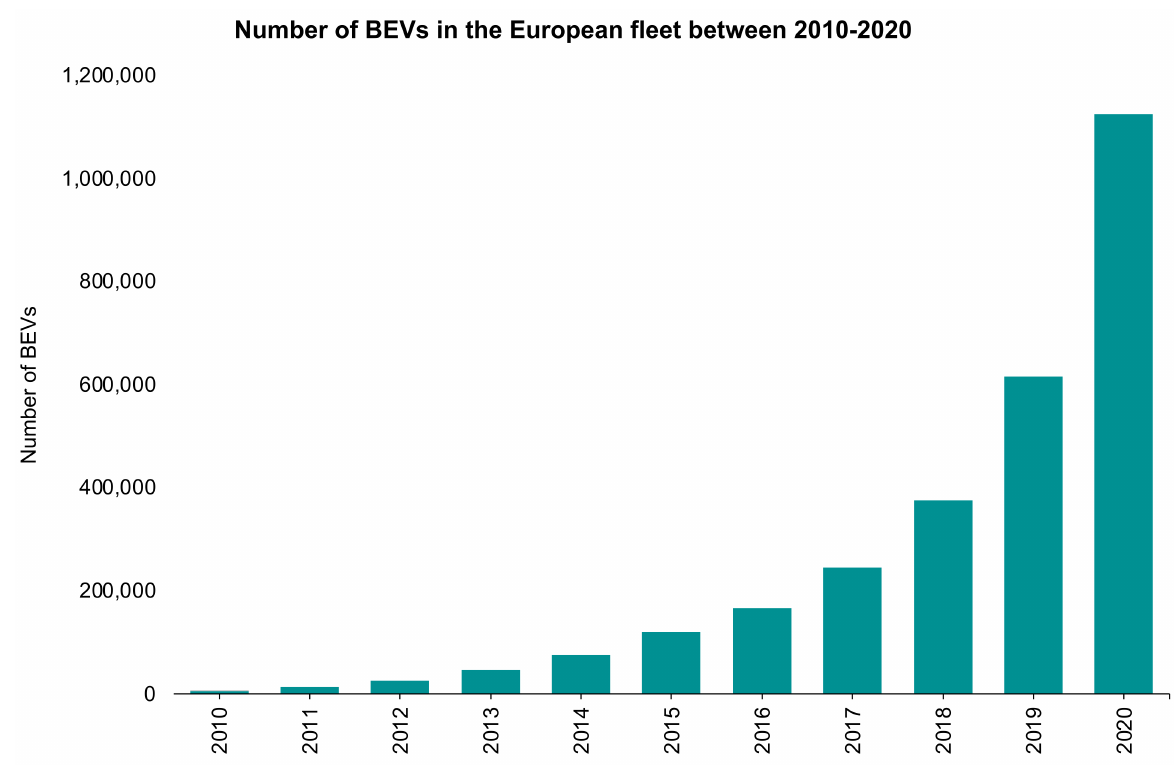
Figure 1. Number of BEVs in the fleet of Europe between 2010–2020. This figure was created with data from European Alternative Fuels Observatory (EAFO)